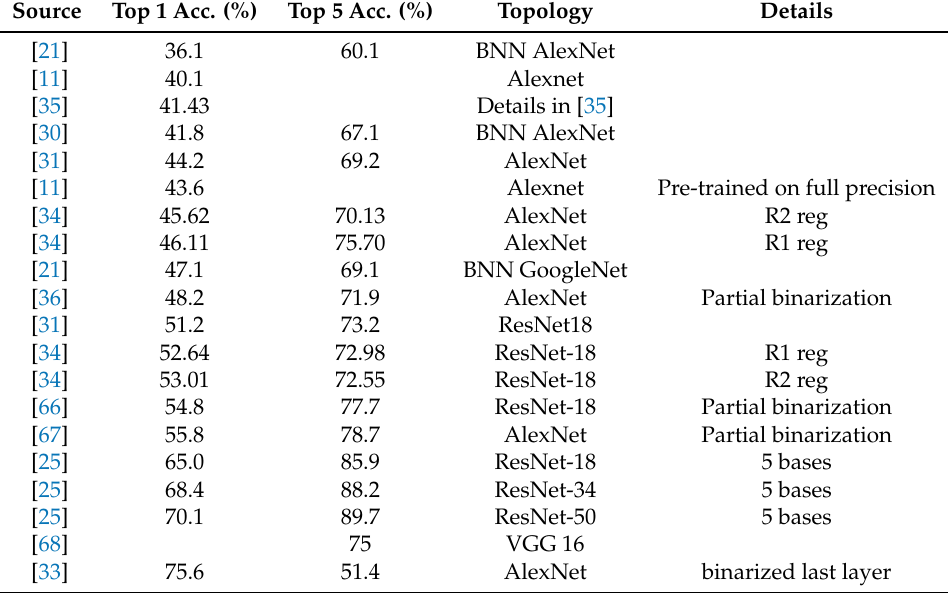
Table 11. BNN accuracies on the ImageNet